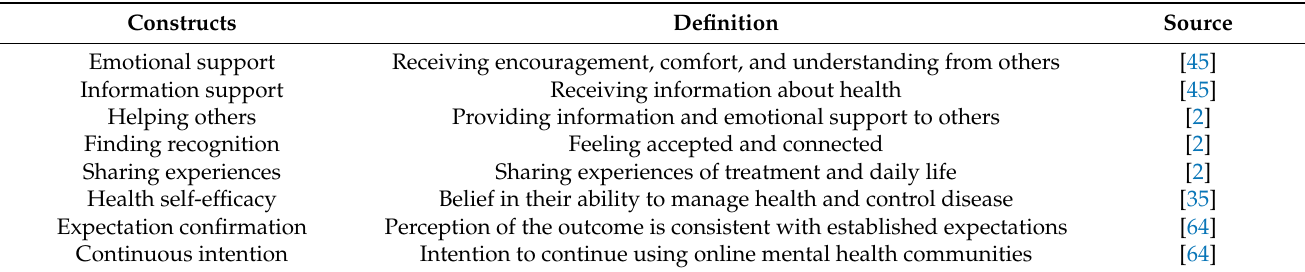
Table 1. Summarization of constructs used in the research